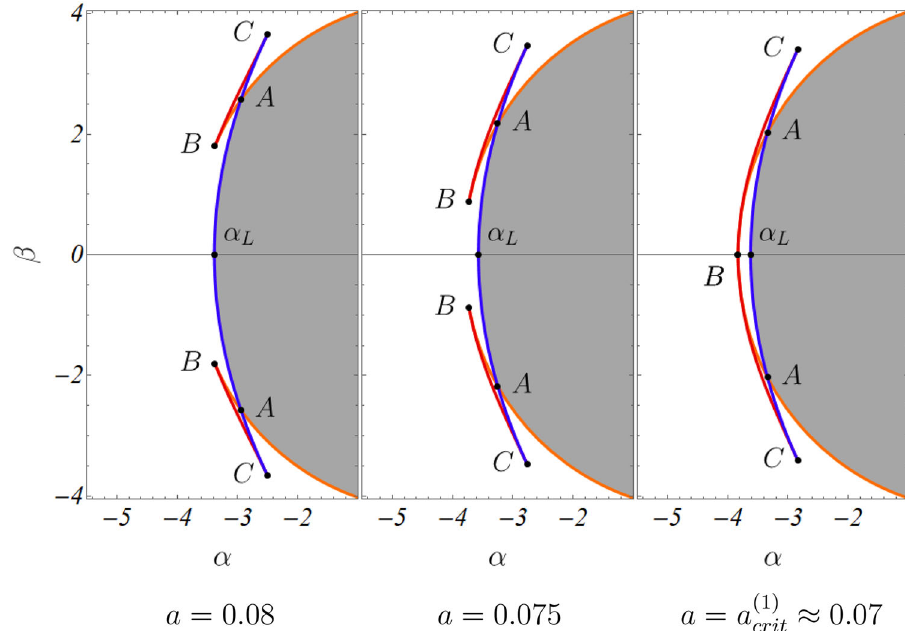
− Fig. 4 Wormhole shadow for the redshift function N = exp ( − r 0 most edges of the shadow, evaluated analytically according to Eqs. (13) r and (14), and the intersection points with the axis α = 0. The shadow r 2 0 ) , and observer inclination angle θ = 90 ◦ . The curves associated 0 r 2 boundary of the Kerr black hole is presented for comparison (black with the light ring at the throat, and the outer light ring are depicted dashed line). The mass of the solutions is set equal to 1 in blue and orange, respectively. The dots denote the left- and right-